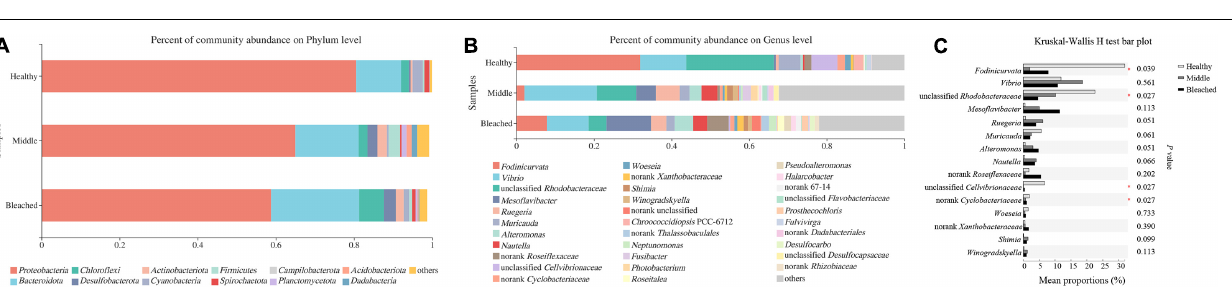
FIGURE 4 | Microbial compositions at (A) the phylum level, (B) the genus level, and (C) the top 15 bacterial genus groups with significant differences among different health statuses of P. onkodes